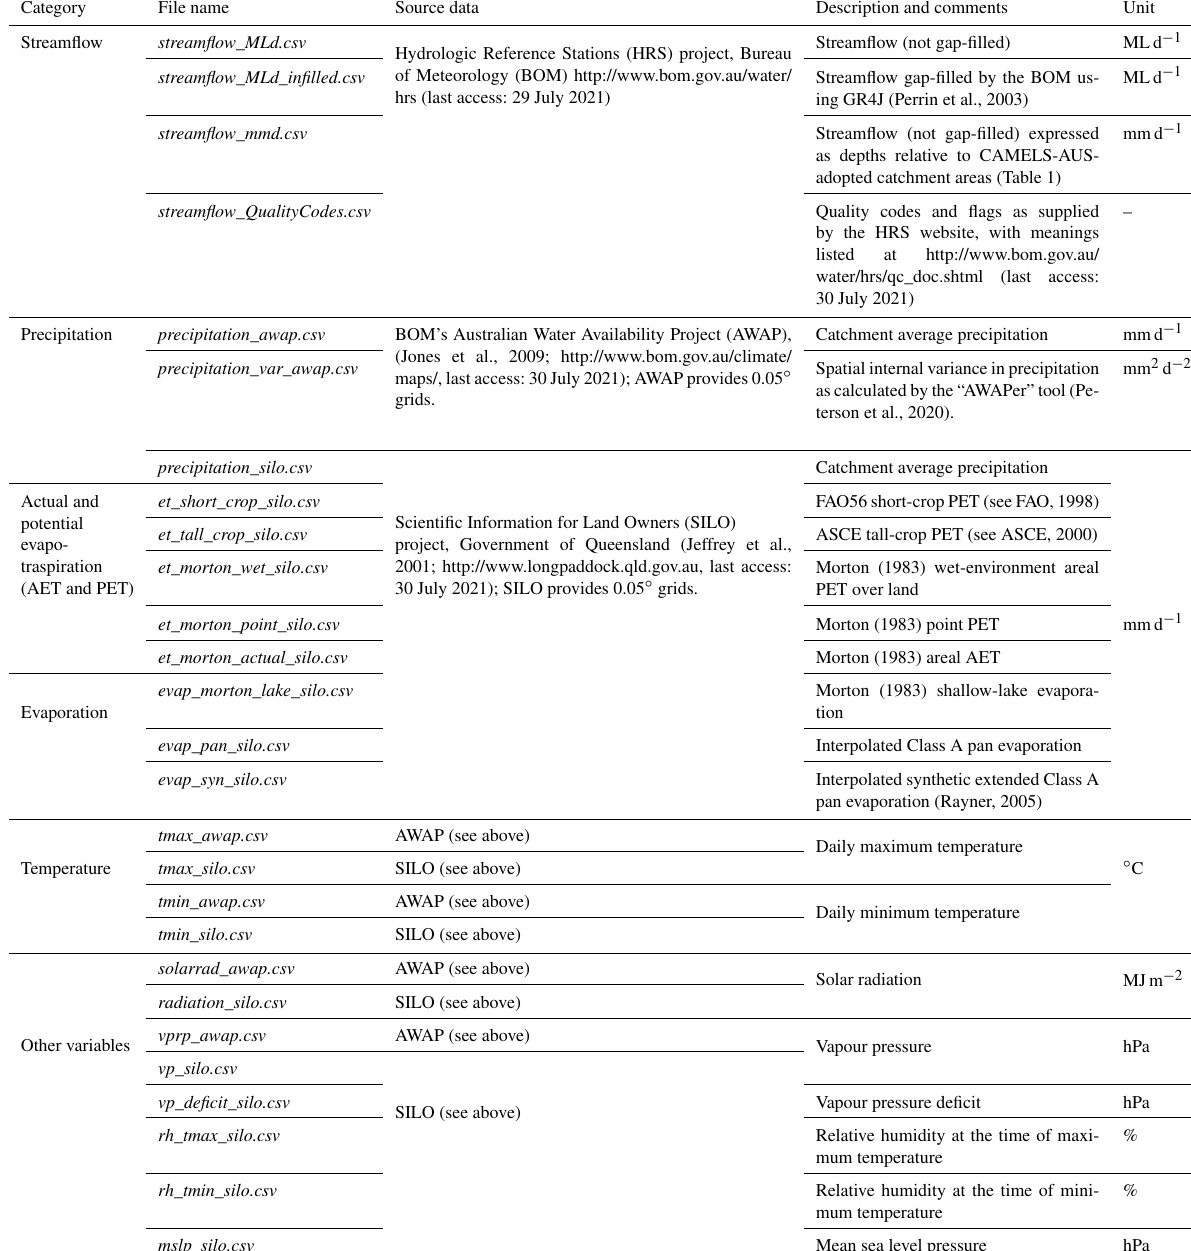
Table 2. Hydrometeorological time series data supplied with CAMELS-AUS. All time steps are daily. All non-streamflow data were pro- cessed as part of the CAMELS-AUS project to extract catchment averages from Australia-wide Australian Water Availability Project (AWAP) and Scientific Information for Land Owners (SILO)